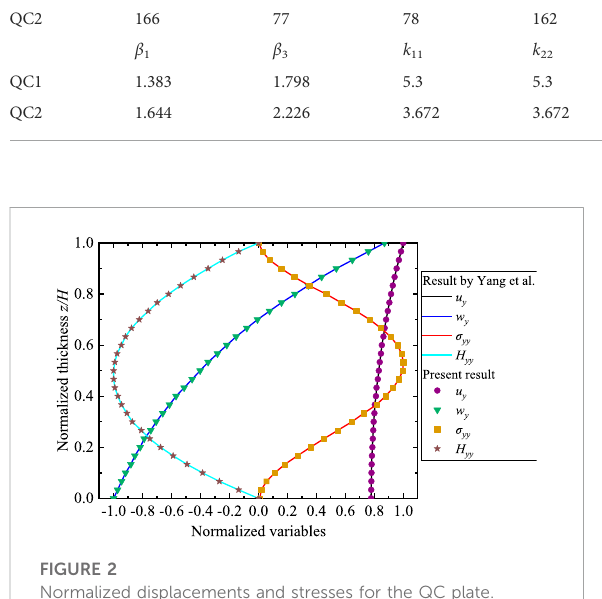
FIGURE 2 Normalized displacements and stresses for the QC